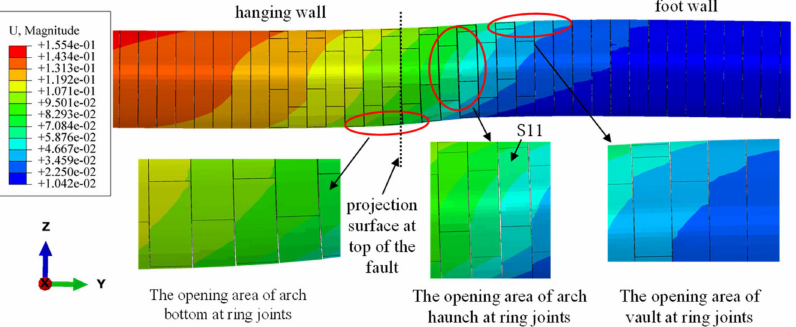
Figure 9. Shield tunnel deformation under normal fault dislocation. Some like +1.554e-01 means 1.554 × 10 − 1 .